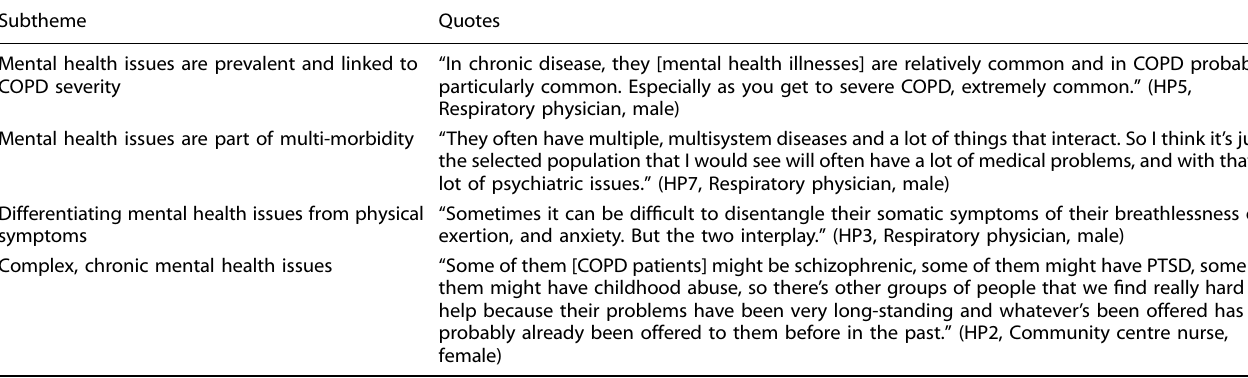
Table 2. Complex physical and mental health illnesses.